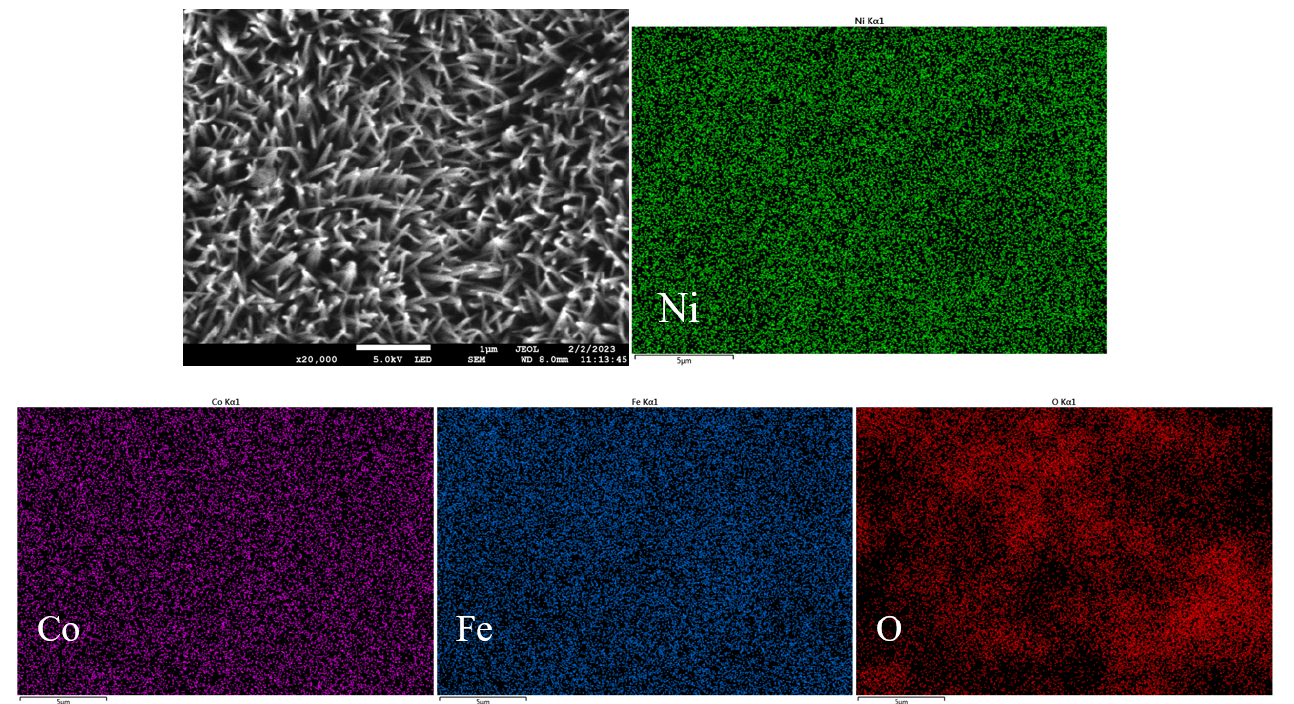
Figure 4. EDS of Ni 4 Co 4 Fe 2 -LDH/NF nanoarrays.